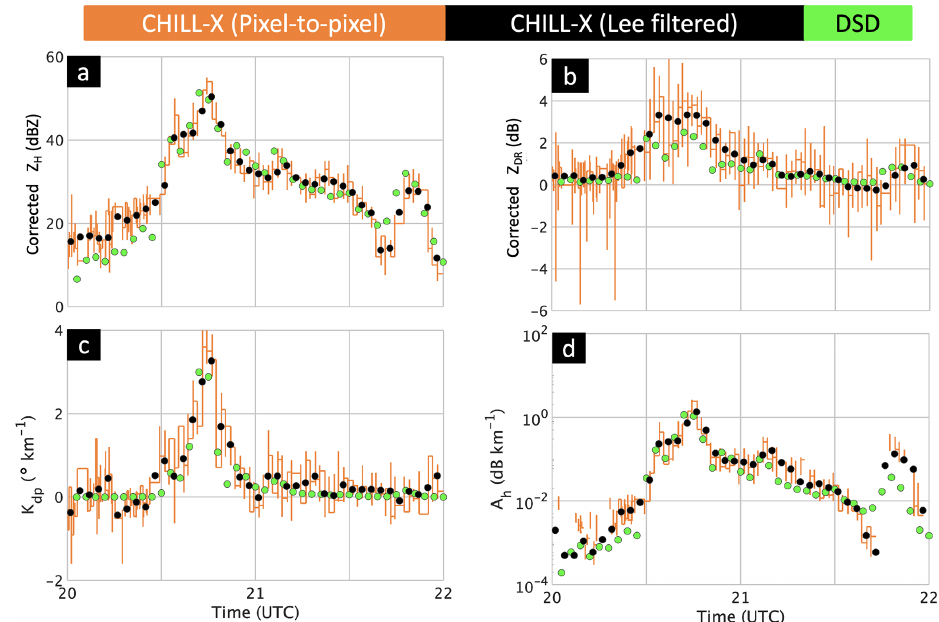
Figure 6. Time series of X-band radar data compared with simulations based on measured complete DSDs and the scattering model described in the text. (a) Corrected Z H from radar showing pixel-to-pixel variations which have been filtered using Lee (1980). (b–d) Same but, respectively, for corrected Z DR , K dp , and A h